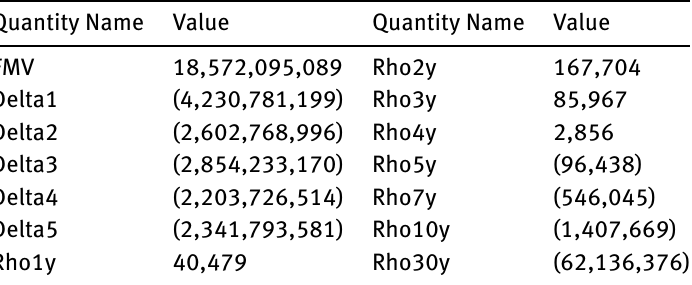
Table 8: The total fair market value, the total partial dollar deltas, and the total partial rhos of the synthetic portfolio. Numbers in parenthesis are negative